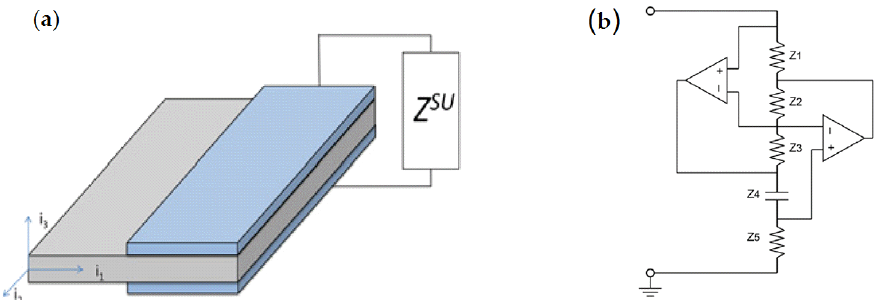
Figure 2. ( a ) A unit cell with shunting through an electrical impedance; ( b ) A circuit diagram of